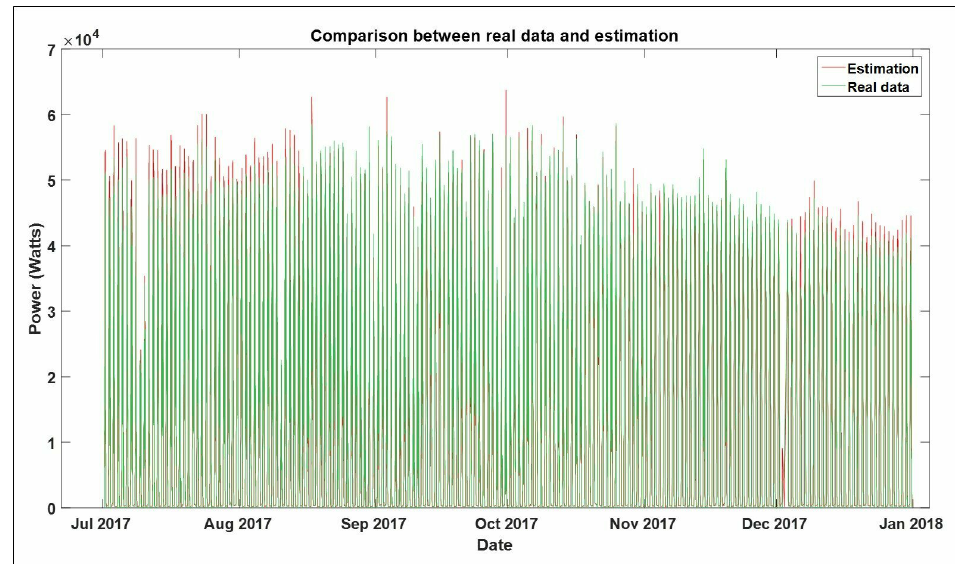
Figure 15. The results obtained from MCS by gradient descent.